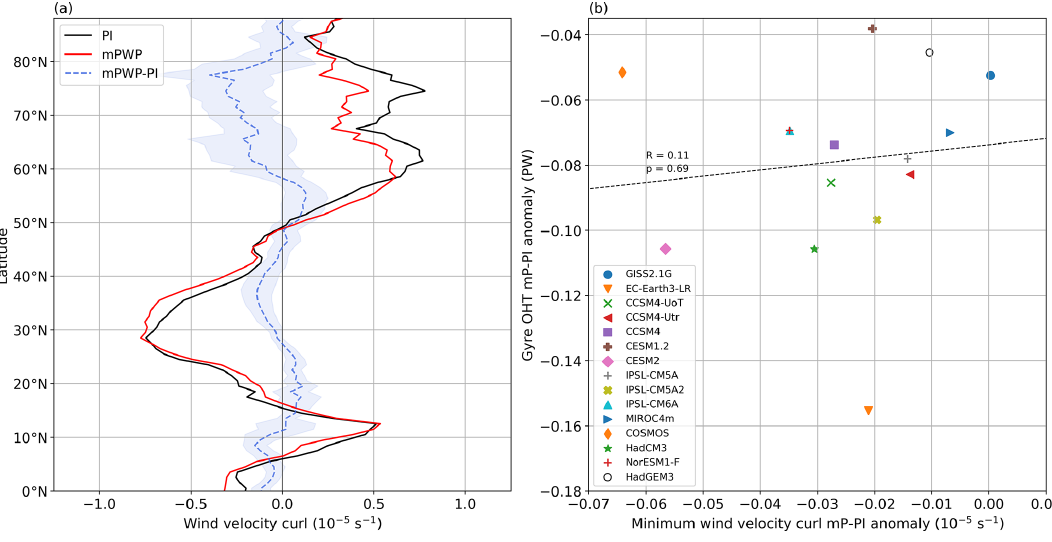
(cid:16) d v (cid:17) − d u in the pre-industrial and mid-Pliocene and their differ- d x d y